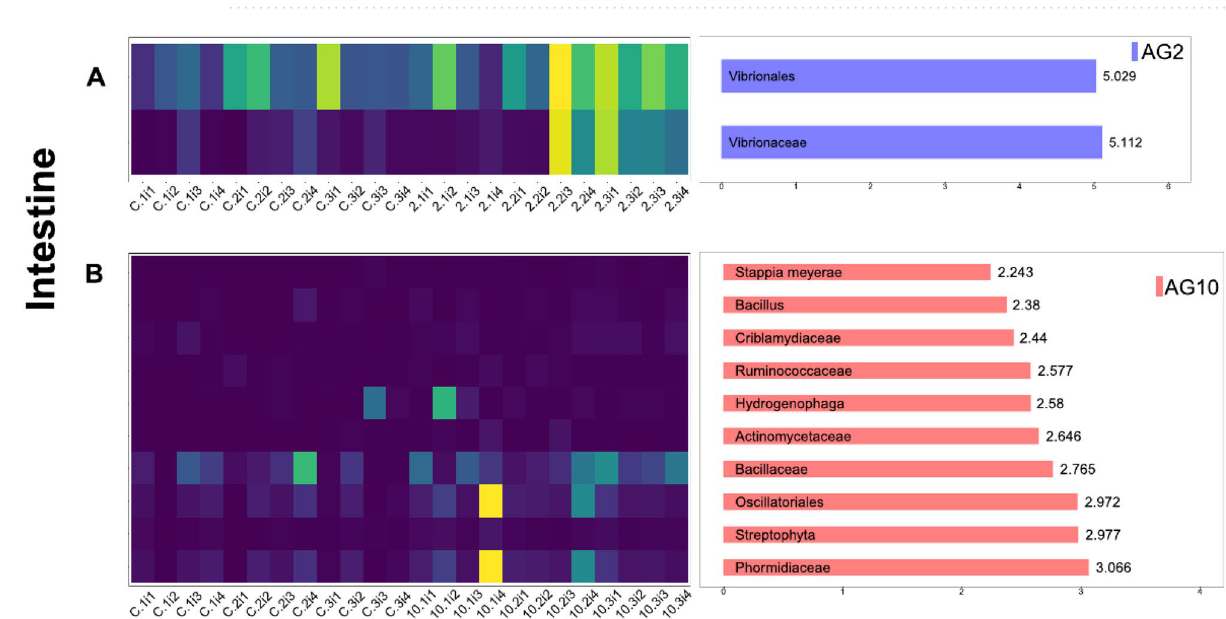
Figure 4. Heatmap of LEfSE results of enriched taxonomic groups in hepatopancreas and their abundance distribution per sample by agavin treatment. ( A ) A2 diet and ( B ) A10 diet. Bar plots represent the log10 LDA score for each classification. Only the top 10 taxonomic levels bearing informative taxonomic labels and LDA effect size > 2(log10) scale are shown. The heatmap shows the abundance of those taxa in the samples with more abundant taxa in yellow.